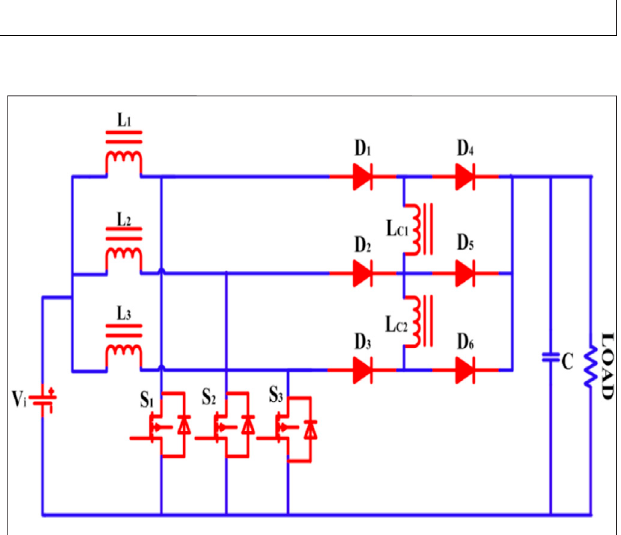
FIGURE 1 | Structure of electric